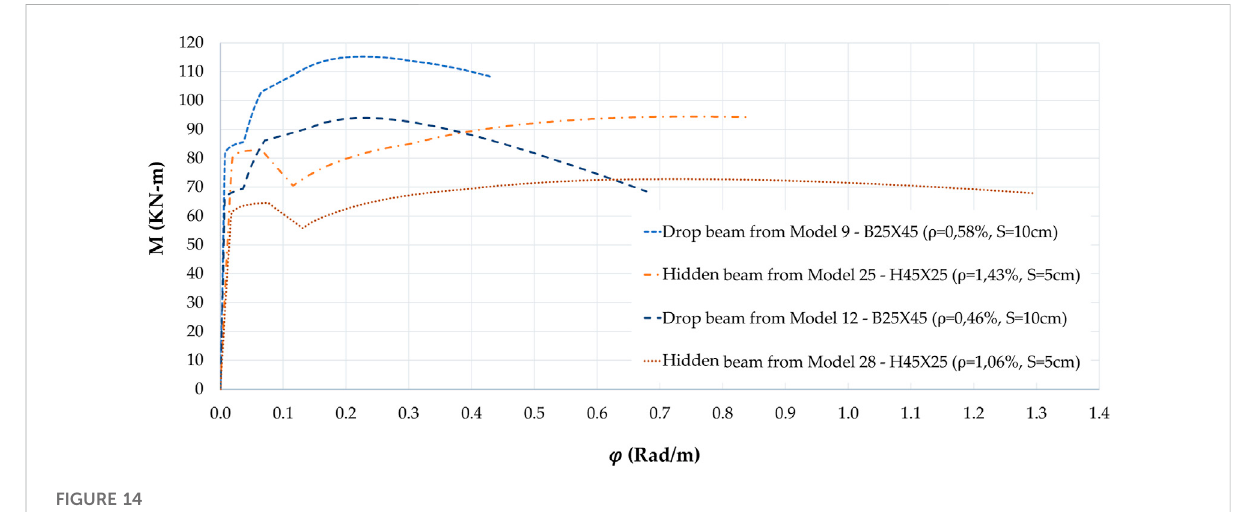
FIGURE 14 Moment-curvature